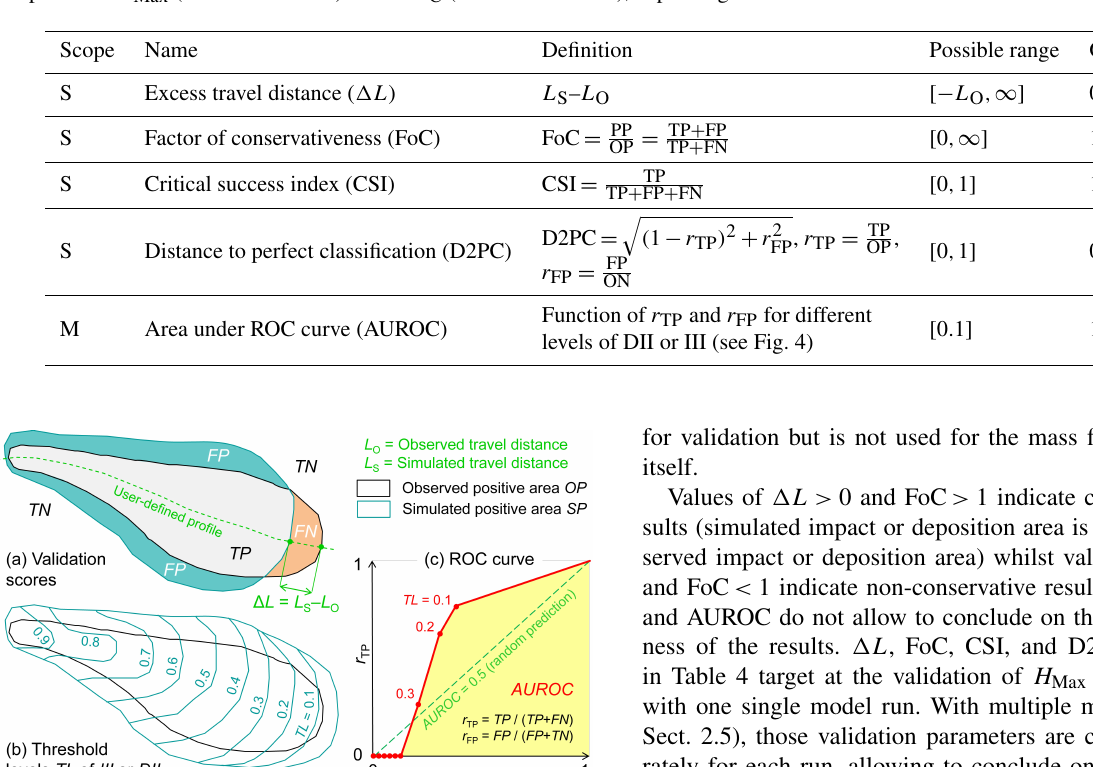
Table 4. Validation criteria used in r.avaflow (see also Fig. 4). S: single model run, binary simulation result; M: multiple model runs, simulation result in the range 0–1. The concepts of CSI and D2PC are taken from Formetta et al. (2016). All validation parameters are computed for H Max (OIA as reference) and/or H C (ODA as reference), depending on which of the reference data are available.